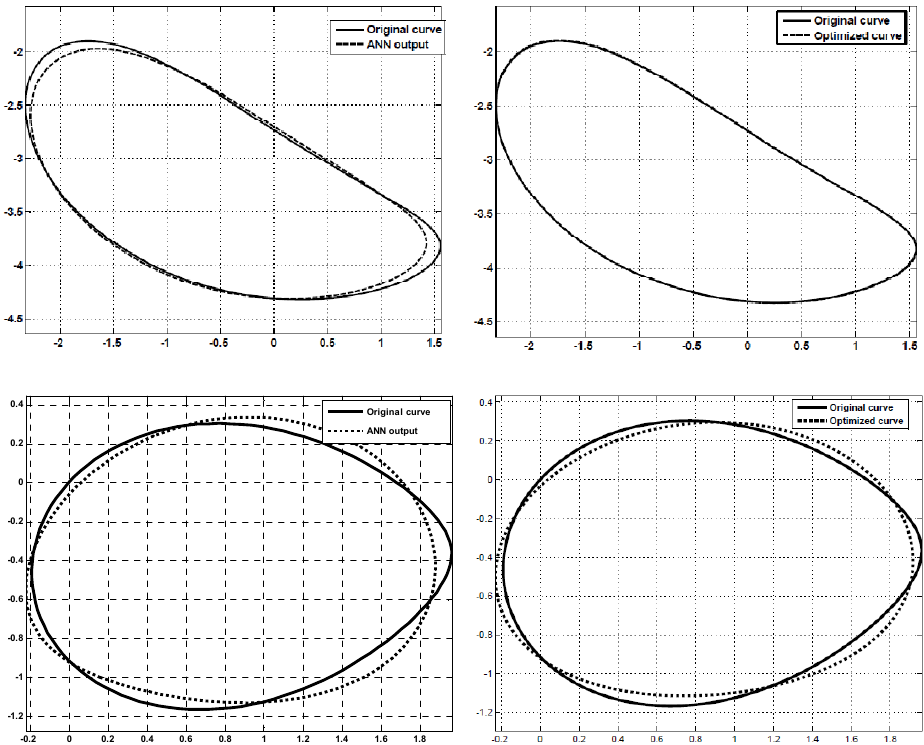
Figure 4. Example 1 (top row) and 2 (bottom row). On the left, the ANN output and on the right the optimized curve, both superposed on the original